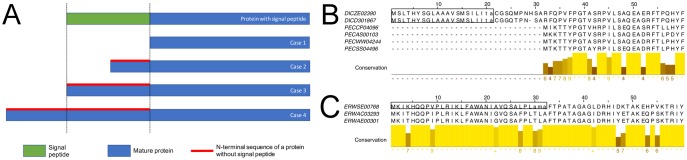
(A) The four possible cases for signal peptide gain and loss events. In proteins devoid of signal peptides the N-teminal sequence can be completely eliminated (case 1), shortened (case 2), have the same length (case 3), or be extended (case 4). Cases one and three are by far the most prevalent ones. (B and C) The first 60 positions in the MSAs of the proteins involved in a signal peptide gain event in “Pectinesterase” OMA group containing two Dickeya and four Pectobacteria (UniProt identifiers: C6CL61, Q47474 (reviewed), C6DIG6, Q6DAZ5, D0KDA3, P55743; reviewed) (B) and the gain event in the “putative Invasin” group containing three Erwinia species (UniProt identifiers: E3DHH7, D4I2A7, unknown) (C). Rectangles indicate signal peptides, with cleavage sites in lowercase letters.